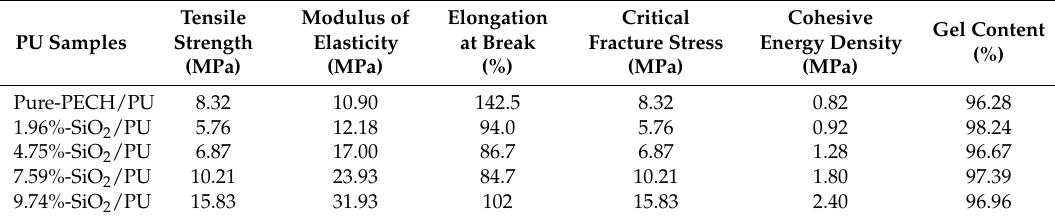
Table 11. Mechanical properties and gel content of PU composites with different nano-SiO 2 contents. PU